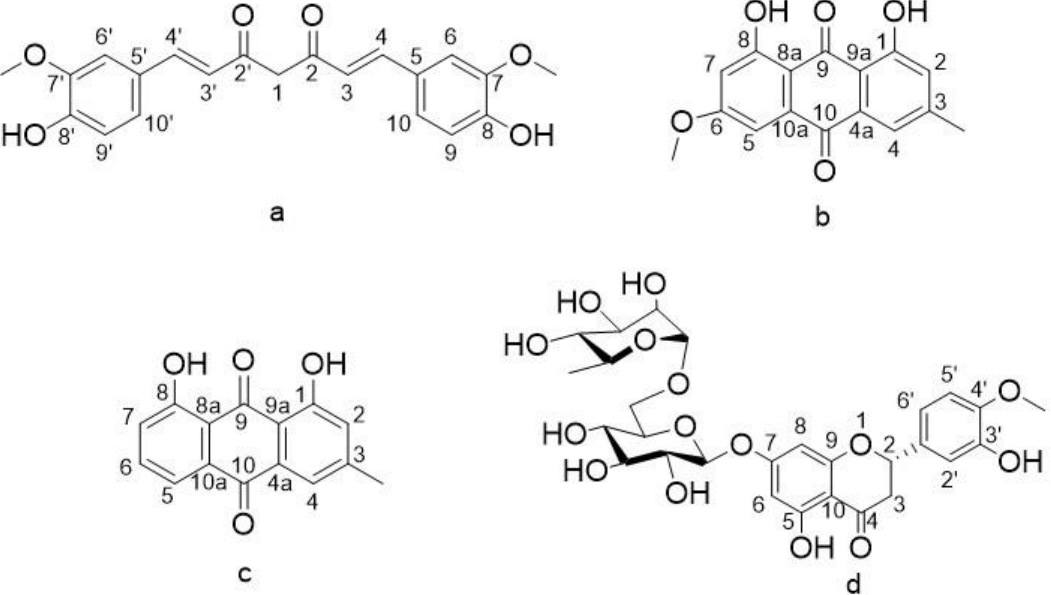
Figure 1. Chemical structures of the isolated compounds: ( a ) Curcumin, ( b ) Physcion, ( c ) Chrysophanol and ( d ) Hesperidin.